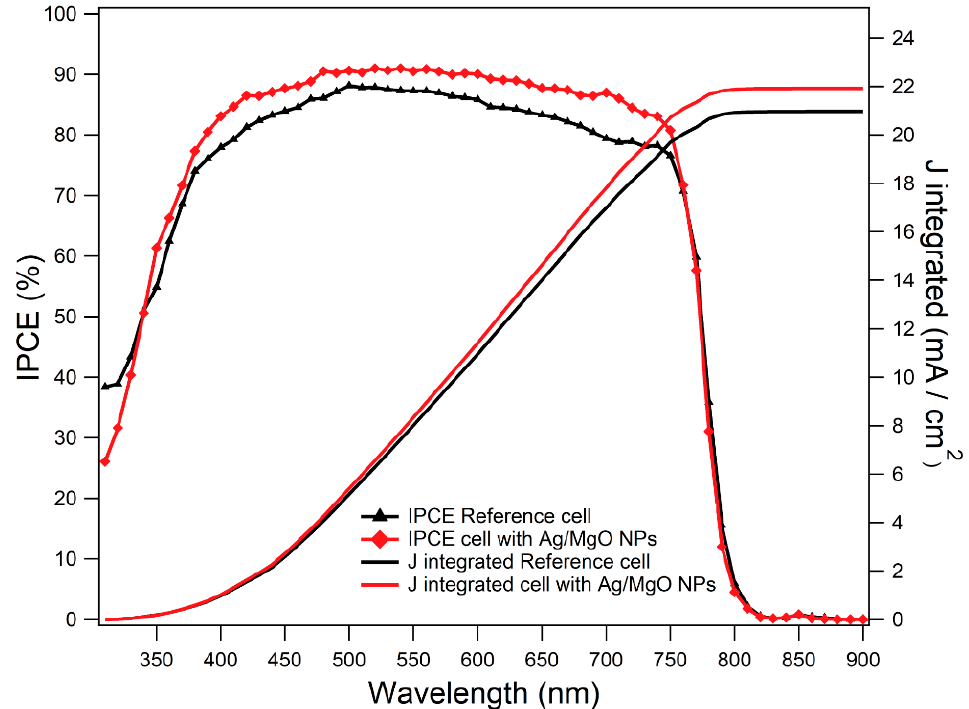
Figure 8. IPCE spectra for both the best ‐ performing device with Ag/MgO NPs (red) and the best